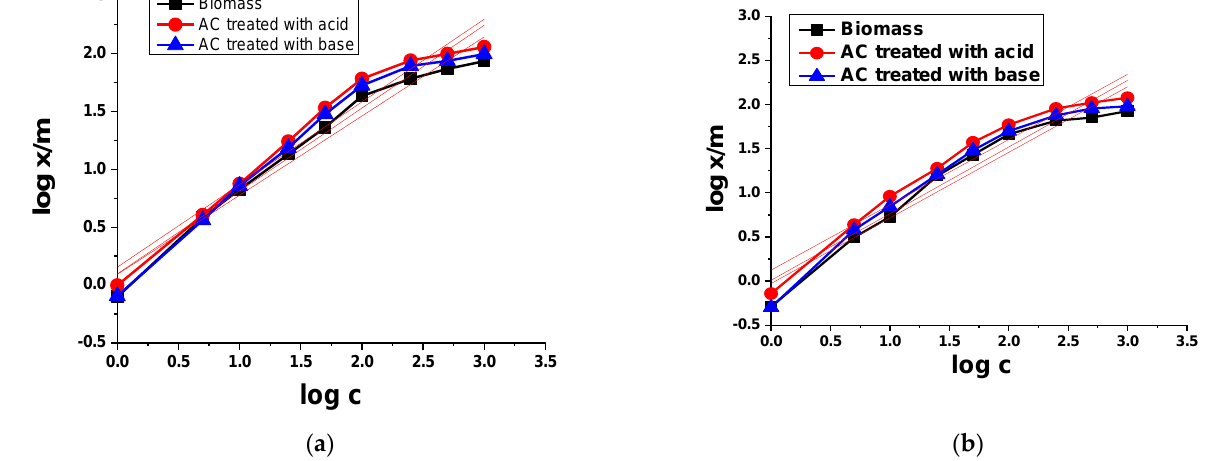
Figure 7. Freundlich adsorption isotherms of ( a ) TB and ( b ) XO on biomass and AC treated with acid and base.